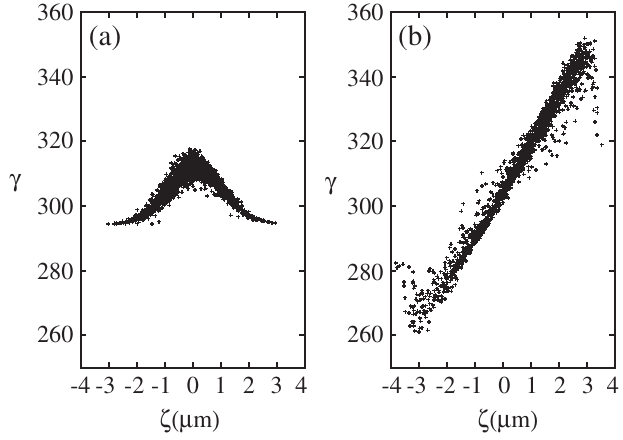
FIG. 8. Electron beam energy distribution at (a) z ¼ 6 cm and (b) z ¼ 1 : 3 m after the laser-plasma accelerator. The initial beam parameters at the exit of the laser-plasma accelerator were (cid:5) z ¼ 1 (cid:2) m , (cid:5) x ¼ 1 (cid:2) m , (cid:3)mc 2 ¼ 150 MeV , and I ¼ 50 kA . A focusing optic is placed at z ¼ 8 cm